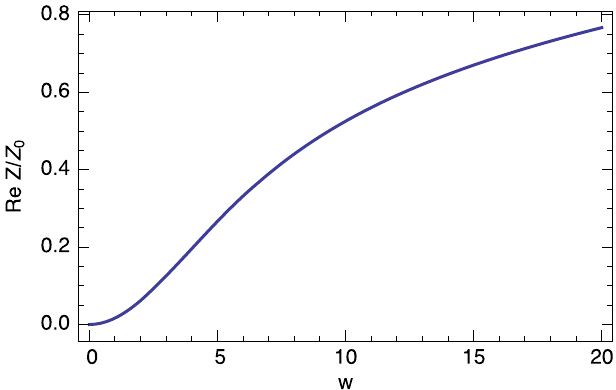
FIG. 4. Impedance of a kink as a function of parameter w ¼ ka θ